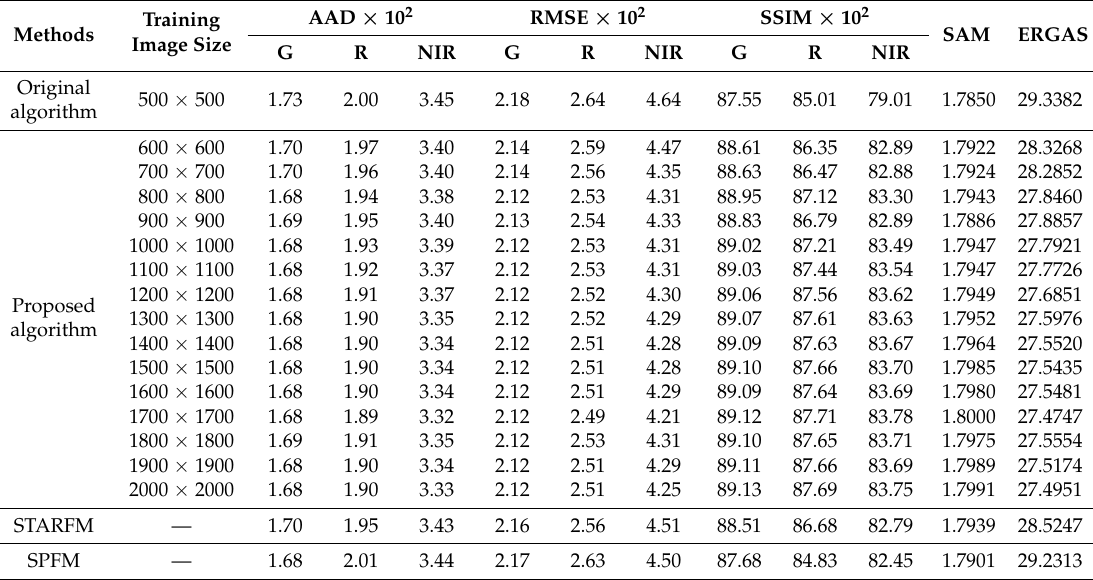
Table 6. Assessment indices of the spatially extended fusion with the urban dataset for modeling reflectance at 12 September